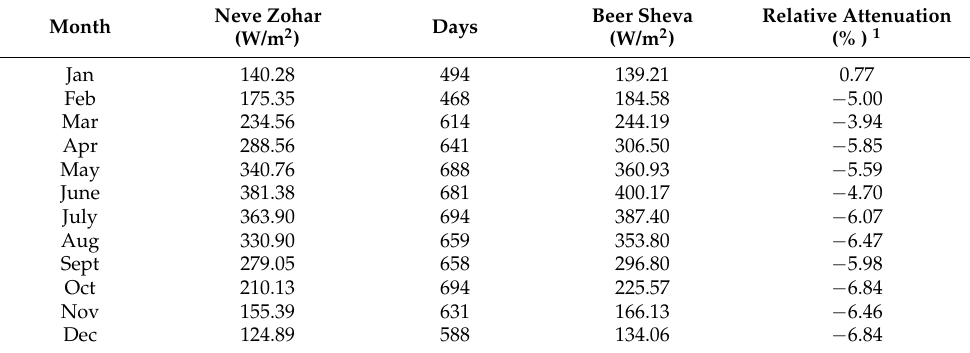
Table 3. Monthly percent daily average relative reduction in UVA irradiation intensities (W/m 2 ). Neve Zohar Month (W/m 2